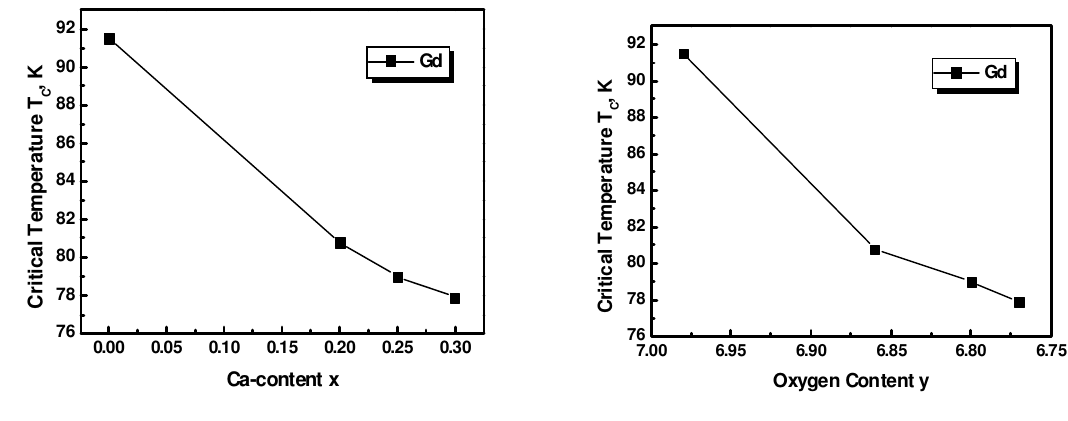
Fig. 3 The critical temperature (T c ) dependence from the Ca-content (x) and the oxygen content (y) in Gd 1 − x Ca x Ba 2 Cu 3 O y